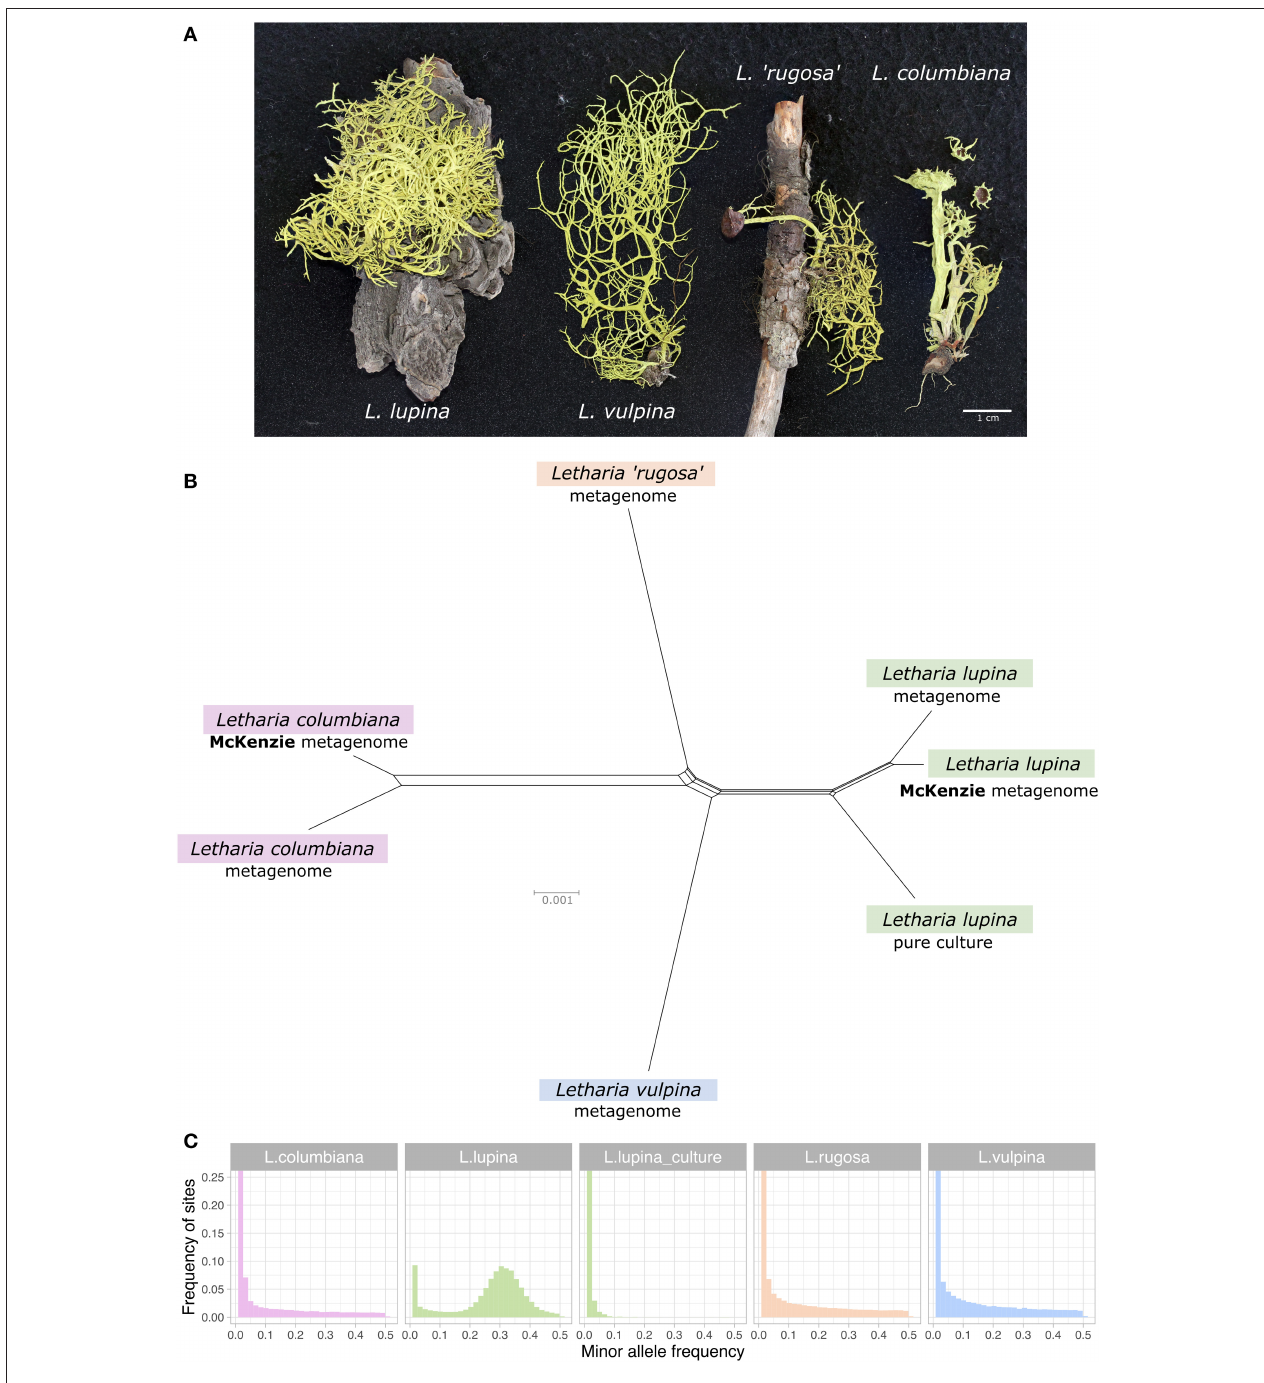
FIGURE 1 | Relatedness and minor allele frequency (MAF) distributions of Letharia specimens. (A) Thalli used for metagenome sequencing in this study. (B) Unrooted NeighborNet split network based on 680 genes from our samples with genomic or metagenomic data available and those from McKenzie et al. (2020). (C) Folded MAF distributions of the metagenomes from Letharia specimens in (A) , as well as the whole genome derived from the pure culture of a single L. lupina spore. All samples show distributions concordant with haploidy, with the exception of the triploid-like metagenome of L. lupina .